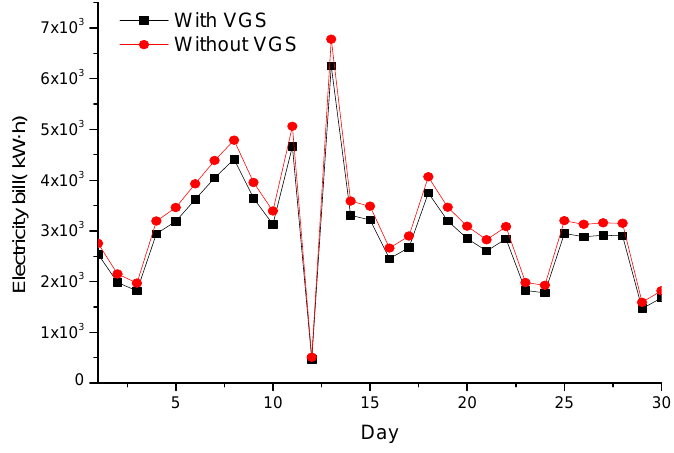
Figure 12. Savings in electricity consumption in one month. (monitoring Date: June 2012).